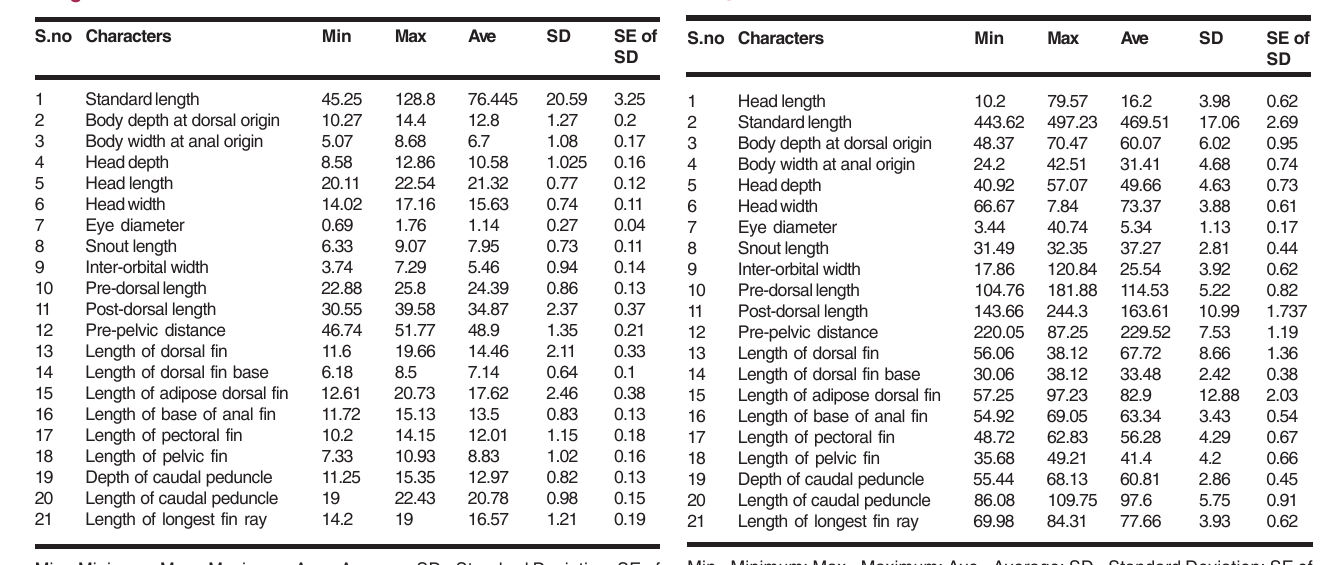
Table3. Morphometric characters of female in % HL except HL given in